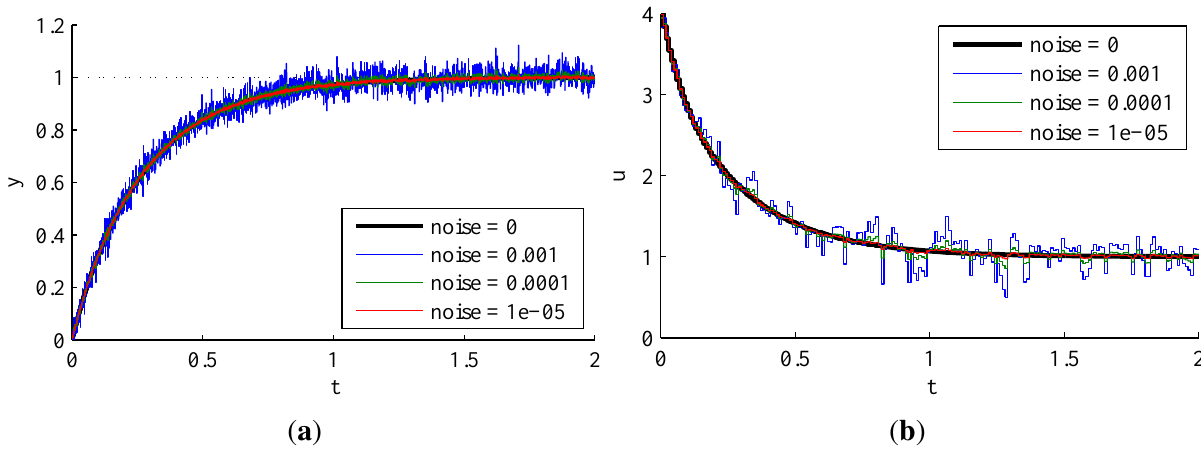
Figure 19. Experiment 4.2.2: influence of different levels of measurement noise